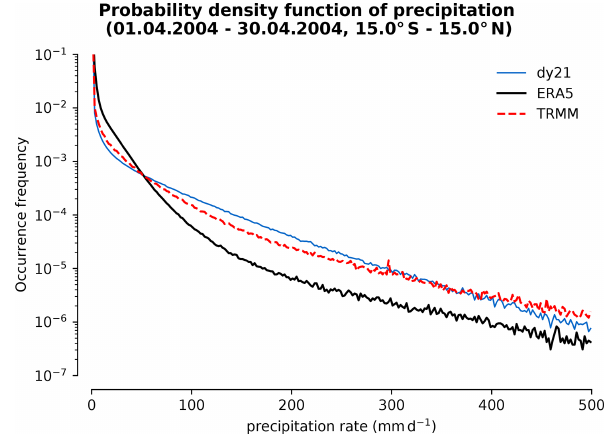
Figure 8. Occurrence frequency of the 3h mean precipitation rate between 15 ◦ S and 15 ◦ N from 1 to 30 April 2004 in the QUBICC simulation dy21, in ERA5, and in TRMM, using 250 bins of 2mmd − 1 width.